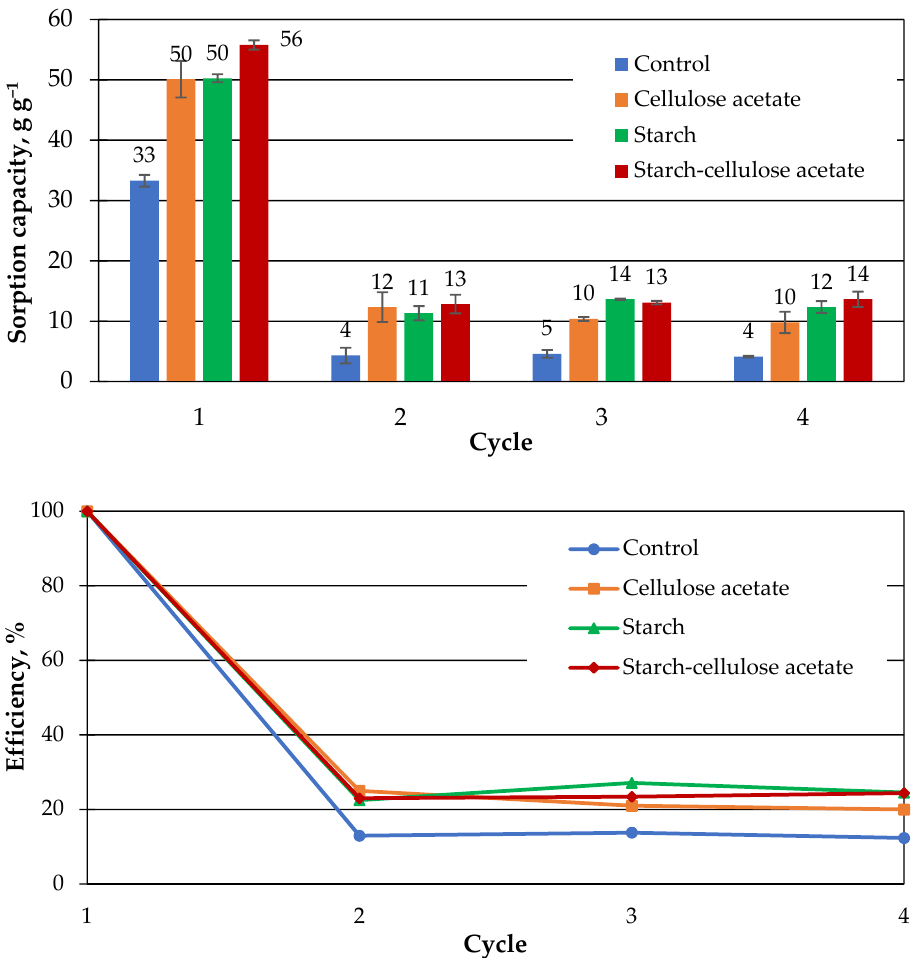
Figure 9. Results of the aerogels with different cross-linkers maximum lubricating oil sorption capacity ( upper figure ) and reuse efficiency of the samples on lubricating oil by each cycle ( lower figure ).